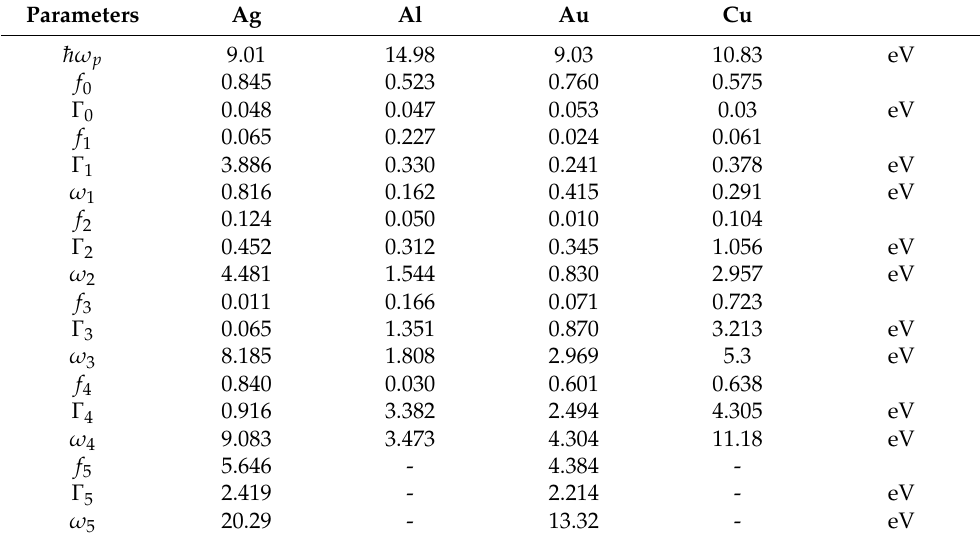
Table 1. Drude–Lorentz parameters: Rakic’s fitting [14].